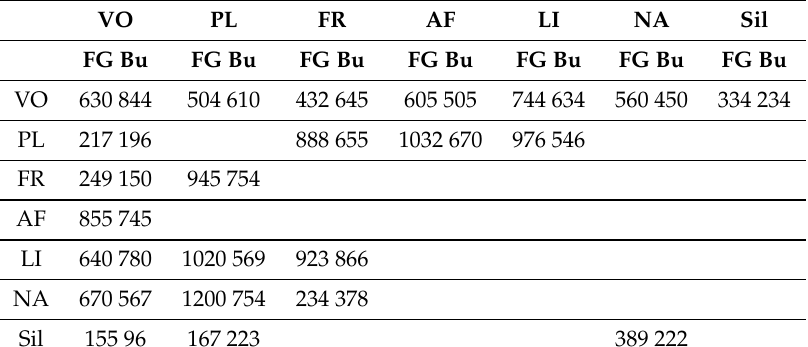
Table 1. Mean squared errors MSE FG − GT of Fuzzy − Genetic and the mean squared error MSE Bu − GT , of Burg where Bu stands for Burg and FG for Fuzzy − Genetic